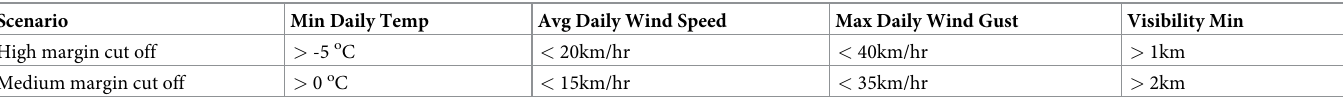
Table 1. UAV flight weather limitations. In order to quantify how many days annually a consumer UAV could be flow in Arviat, Nunavut, we established two categories of minimum parameters and assessed 5 years of daily weather data. Limits were based on manufacture recommendations, legal limits, and tests conducted in Arviat.